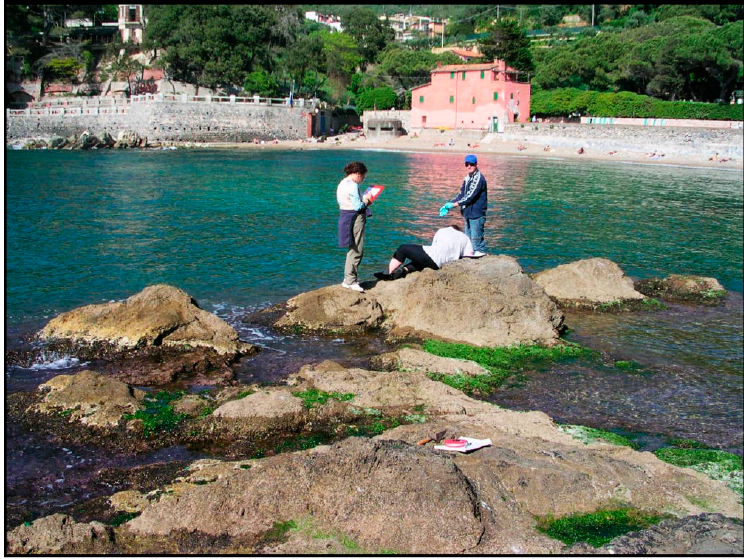
Figure 6. Site SS1 first ‐ order platform.